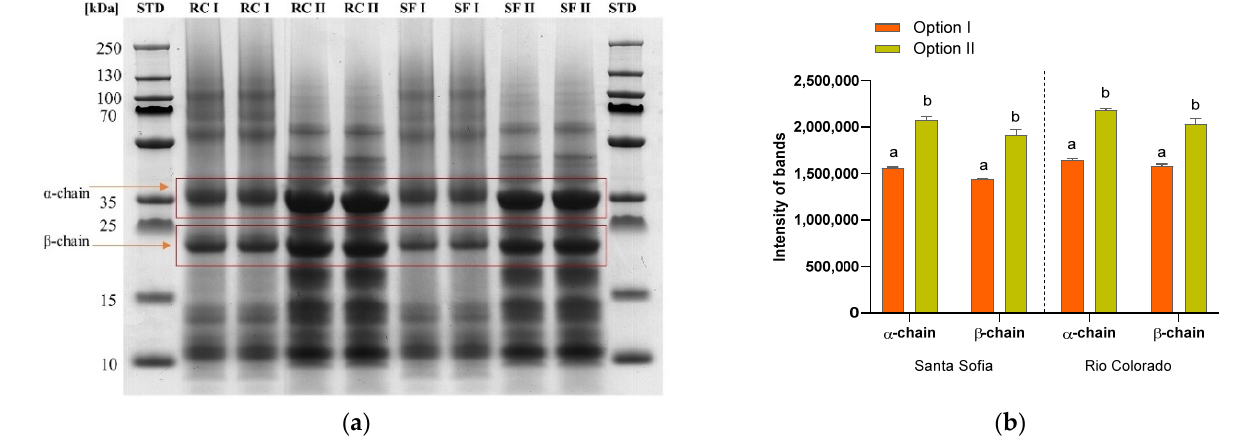
Figure 2. ( a ) SDS-PAGE of Rio Colorado and Santa Sofia Company green coffee beans; ( b ) intensity of α and β chains. RC: Rio Colorado Company; SF: Santa Sofia Company. Data are expressed as means ± standard deviation ( n = 3). Different letters indicate significantly different values for each group ( p < 0.05, ANOVA, Tukey’s test).